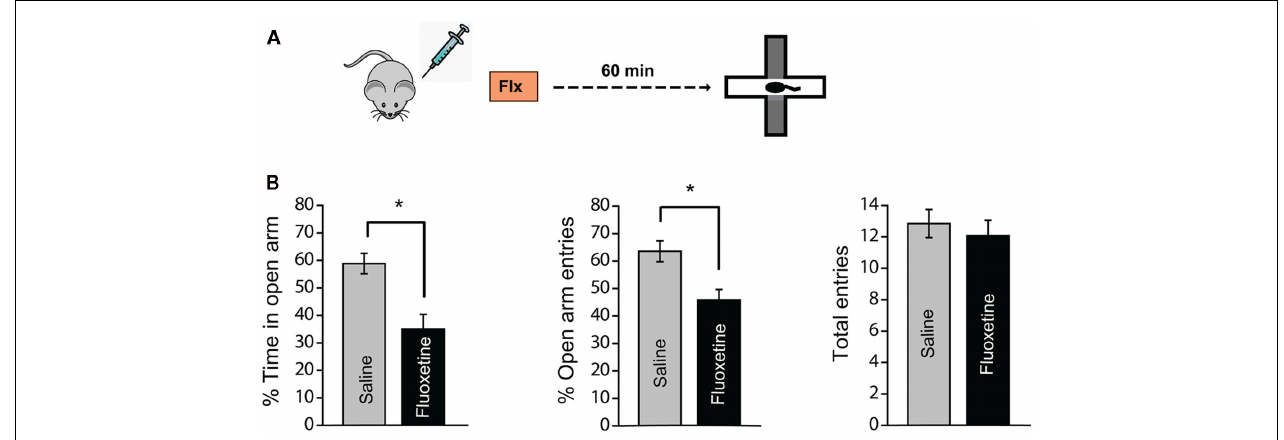
percentage of open-arm entries (middle). Fluoxetine injected rats spent less time in the open-arm and made fewer entries to the open-arm when compared to saline injected rats indicating high anxiety levels.The total entries (right) were not different suggesting that there was no difference in locomotor activity between the two groups. Saline: N = 13, Fluoxetine: N = 12. Error bars represent SEM; * p <